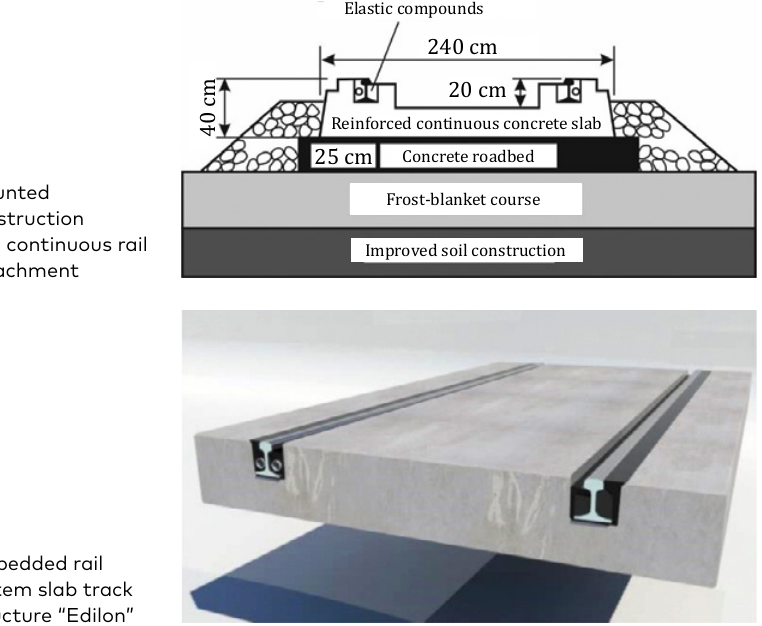
Figure 4. Infundo-Edilon slab track